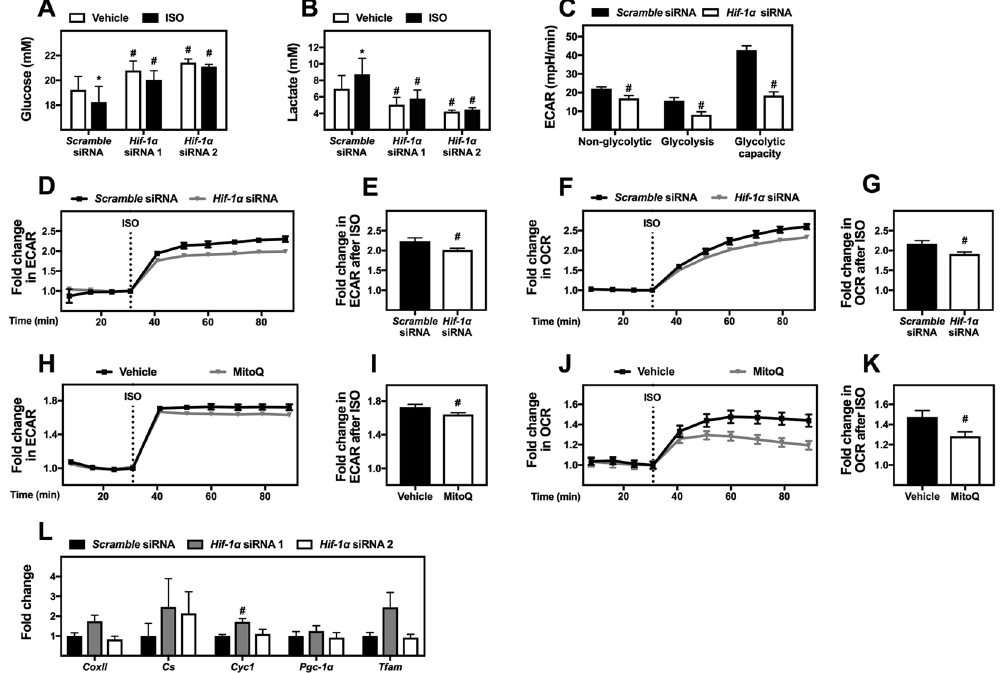
Figure 7. The importance of HIF-1 α for β -adrenergically stimulated glycolysis and thermogenesis. Mature brown adipocytes (WT-1) were reverse transfected with scramble siRNA or two different siRNAs against Hif-1 α . Four days later, the adipocytes were stimulated with vehicle or 1 μ M ISO for 6 h, after which glucose ( A ) and lactate ( B ) measurements were performed on the medium. ( C ) Representative results from Seahorse XF Glycolysis Stress Tests performed on mature adipocytes (WT-1), which were reverse transfected with scramble siRNA or an siRNA against Hif-1 α (siRNA 1) (n = 3). ( D–G ) Extracellular acidification rate (ECAR) and oxygen consumption rate (OCR) were measured four days after transfection (n = 5). ( D ) Representative time- course of ECAR during basal conditions and after injection of 1 μ M ISO. ( E ) Fold change in ECAR between the basal level and the measurement 30 min after ISO stimulation. ( F ) Representative time-course of OCR during basal conditions and after injection of 1 μ M ISO. ( G ) Fold change in OCR between the basal level and the measurement 30 min after ISO stimulation. ( H–K ) ECAR and OCR were measured at day 8 on a Seahorse XF96 Flux Analyzer after treatment with 5 μ M MitoQ or vehicle (n = 4). ( H ) Representative time-course of ECAR during basal conditions and after injection of 1 μ M ISO. ( I ) Fold change in ECAR between the basal level and the measurement 30 min after ISO stimulation. ( J ) Representative time-course of OCR during basal conditions and after injection of 1 μ M ISO. ( K ) Fold change in OCR between the basal level and the measurement 30 min after ISO stimulation. ( L ) Total RNA was isolated from mature adipocytes (WT-1) transfected with scramble siRNA or two different siRNAs against Hif-1 α . Relative gene expression was analyzed by RT-qPCR and presented as fold change relative to the scramble siRNA-transfected cells. The genes measured were Cyc1 , CoxII , Cs, Pgc-1 α and Tfam (n = 3). mRNA expression levels were normalized to Tbp . Data represent mean + SEM (panel C-K) or mean of means + SEM (panel A, B and L). * p < 0.05 versus vehicle-treated cells. # p < 0.05 versus scramble siRNA transfected